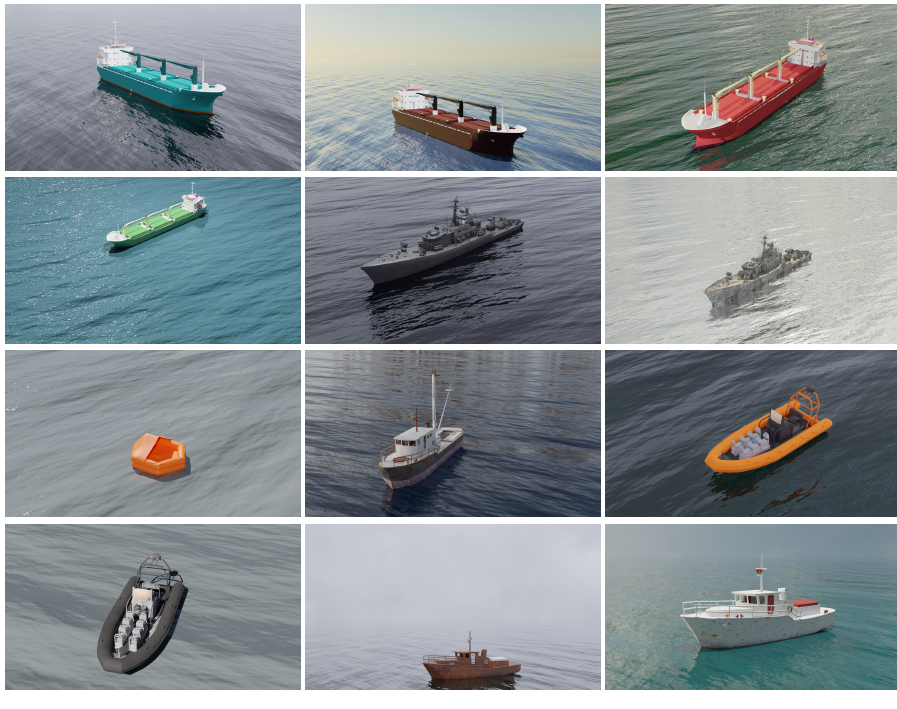
Figure 4. Different types of vessels present on the MarSyn dataset.